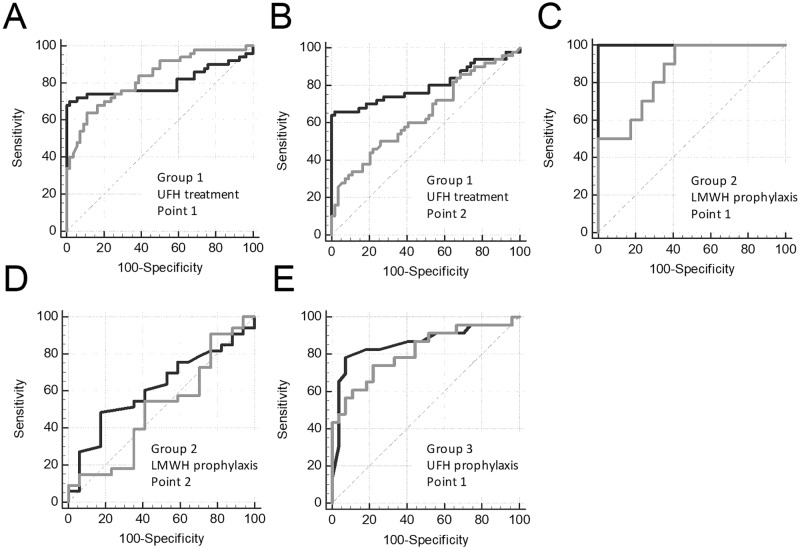
Heparin effect on TGT vs TD.ROC curves for ETP in TGT (gray lines) and V in TD (black lines) for treatment with UFH (group 1) at Point 1 (A) and Point 2 (B) and prophylaxis with LMWH (group 2) at Point 1 (C) and Point 2 (D) or UFH (group 3) at Point 1 (E). Data of the same patients before the first heparin injection were used as controls.